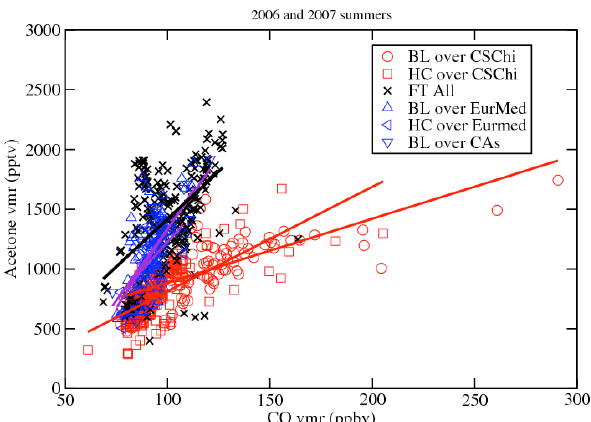
Figure 10. Acetone/CO signature in various air masses sampled in 2006 and 2007 summers. Linear regressions are plotted in red for HC and BL air masses sampled over CSChi, in purple for these same air masses but sampled over EurMed and Central Asia (CAs) and in black for all FT air masses sampled everywhere.